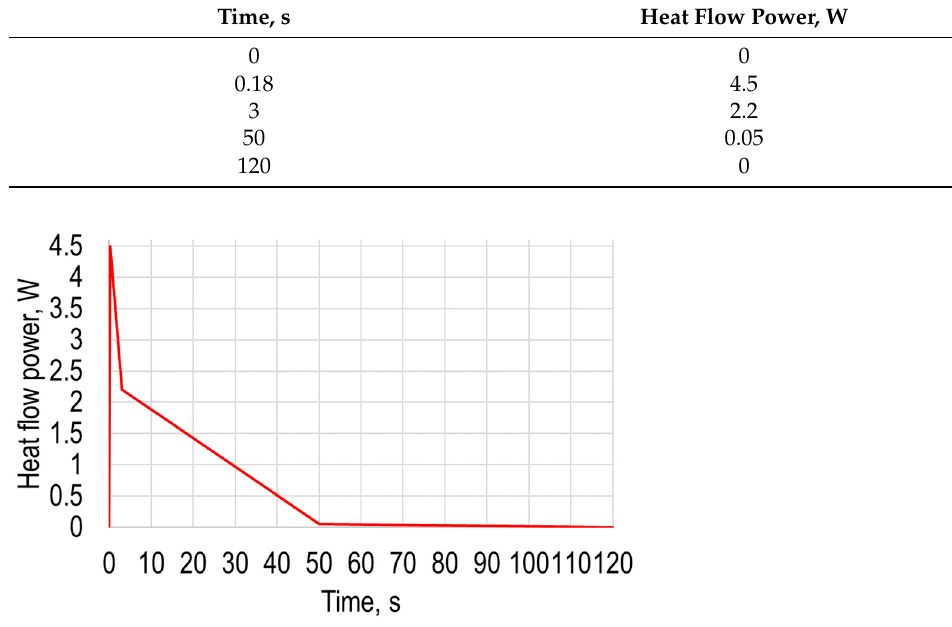
Figure 9. Excitation heat flow curve.